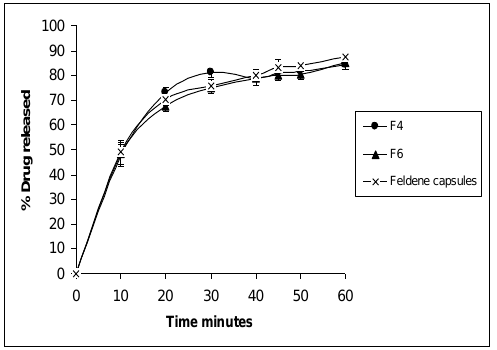
Figure 4: Comparison of the release profile of the prepared capsules with the marketed